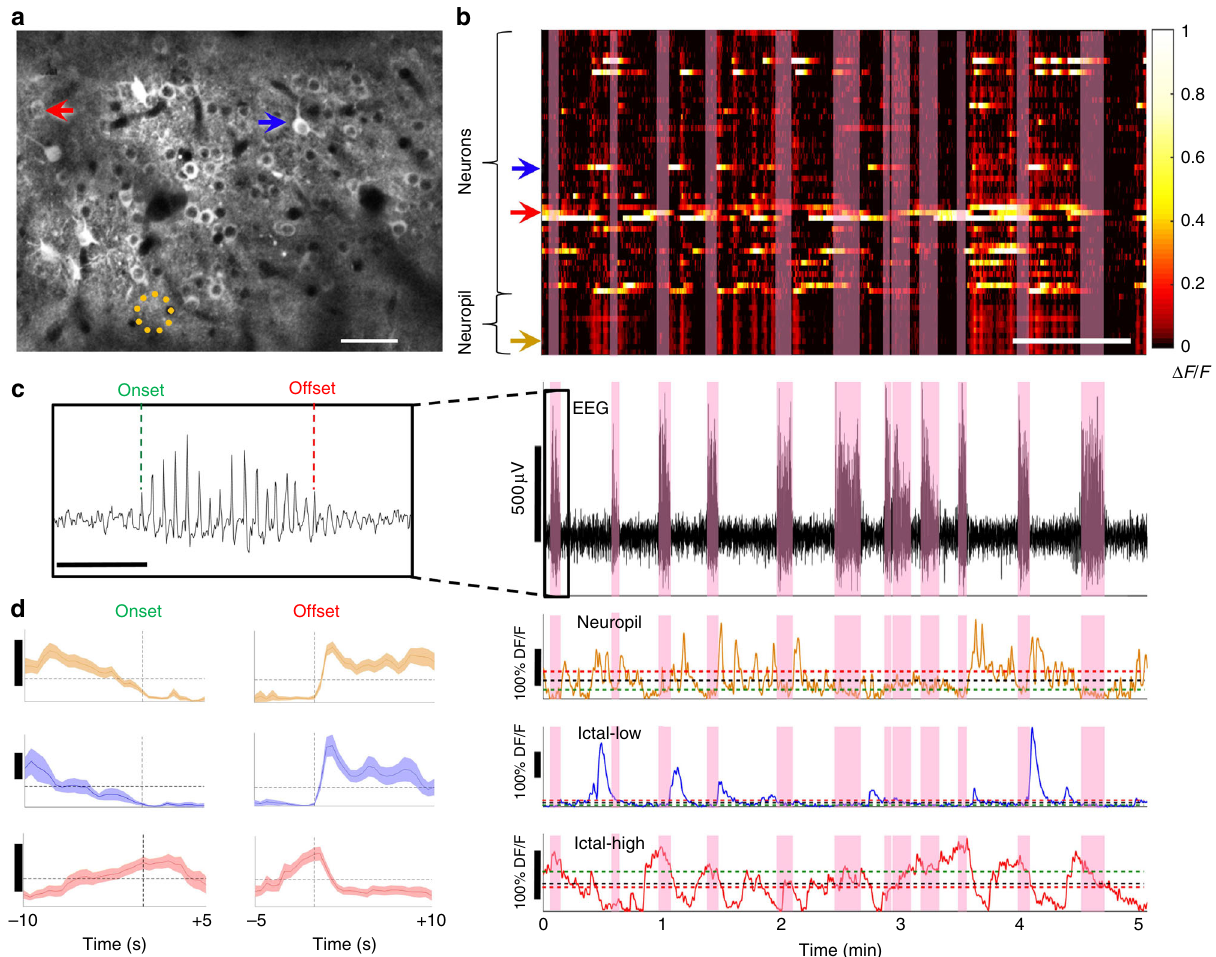
Fig. 1 In vivo 2-photon microscopy and EEG in visual cortex of stargazer mice. a Typical fi eld of view for in vivo imaging; GCaMP6- fi lled neurons in L2/3 of visual cortex (red arrow — neuron with high activity during seizures (ictal-high); blue arrow — neuron with low activity during seizures (ictal-low); orange dotted circle = neuropil patch. Scale bar = 50 µ m. b Top: Calcium activity for each neuron/neuropil patch over time with seizure epochs highlighted in pink (horizontal bar = 1 min). Bottom: concomitant EEG, and traces of calcium activity from the depicted neuropil, ictal-low neuron, and ictal-high neuron shown in a . Mean ictal activity (green dashed line), mean interictal activity (red dashed line), and overall mean activity (black dashed line) are plotted. Inset c shows de fi nition of seizure onset and offset at fi rst and last spike of the seizure, respectively (bar = 1 s). d Average activity (mean ± s.e.m., vertical bar = 20% Δ F / F ) of an exemplary neuropil patch (top), ictal-low neuron (middle), and ictal-high neuron (bottom) are shown, time-locked to the seizure onset (left) and offset